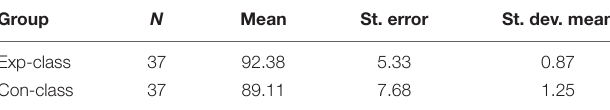
TABLE 3 | Group statistics (post-test).